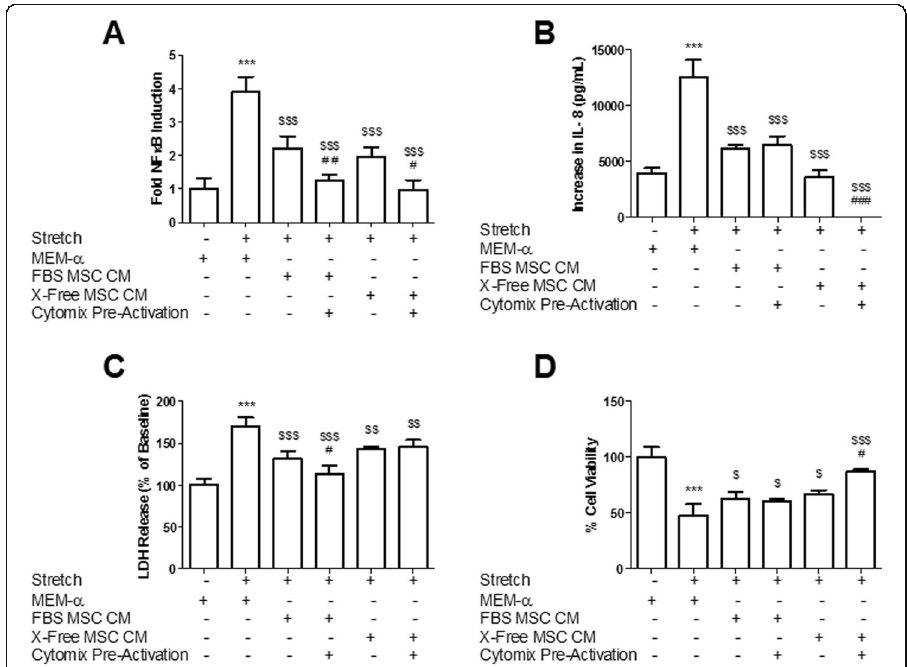
Fig. 1 Pre-activation of hMSCs enhances the efficacy of CM in attenuating mechanical stretch injury. Mechanical stretch induction of NF- κ B was reduced by FBS- and XF-cultured MSC CM in comparison with the MEM- α stretch control ( a ). Pre-activation of both FBS- and XF-cultured MSCs further enhanced the ability of the MSC CM to attenuate NF- κ B when compared to naive MSC CM. Mechanical stretch-induced release of IL-8 ( b ) was ameliorated by both naive CM groups but more significantly so by the pre-activated XF-hMSC CM ( b ). Mechanical stretch-induced LDH release again was attenuated by all the MSC CM groups, but more so in the pre-activated FBS MSC CM group ( c ). The decrease in cell viability, as induced by mechanical stretch, was also abrogated by both naive MSC CM treatments but was more enhanced in the pre-activated XF-hMSC CM group ( d ). *** P < 0.001 versus MEM- α non-stretch control; $ , $$ and $$$ P < 0.05, 0.01 and 0.001, respectively, versus MEM- α stretch; # , ## and ### P < 0.05, 0.01 and 0.001, respectively, versus respective naive FBS or XF-hMSC CM. MEM- α non-stretch control, n = 6; MEM- α stretch control, n = 5 or